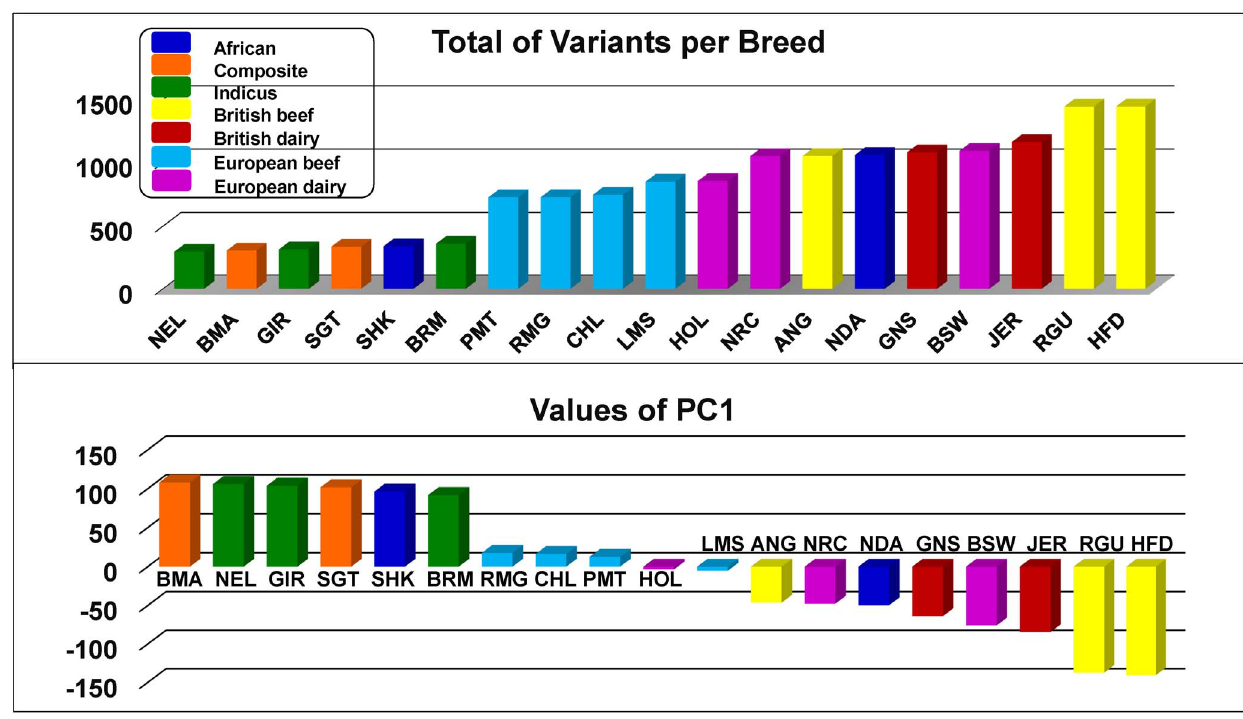
Figure 4. Number of structural variations per breed. Genome wide averaged number of structural variations per breed.